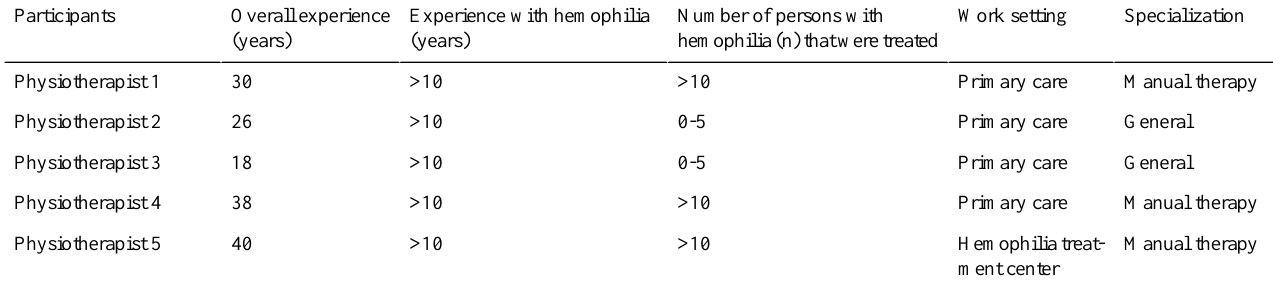
Table 2. Focus Group 2: Demographic characteristics of the participating